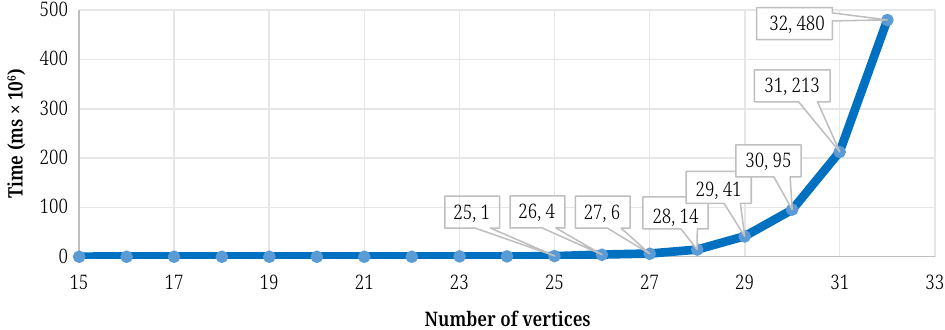
Fig. 7. Effect of increasing the number of vertices in the graph on the execution time of the exact algorithm